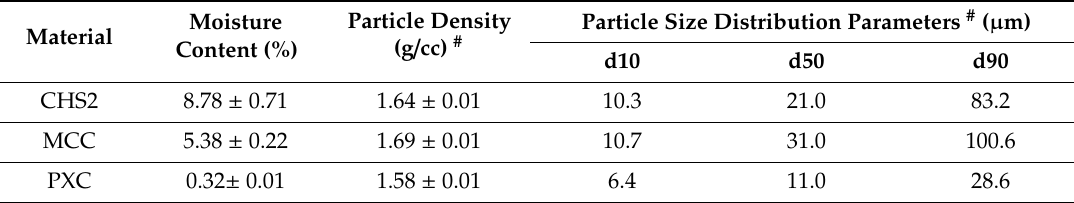
Table 2. Properties of the unprocessed experimental